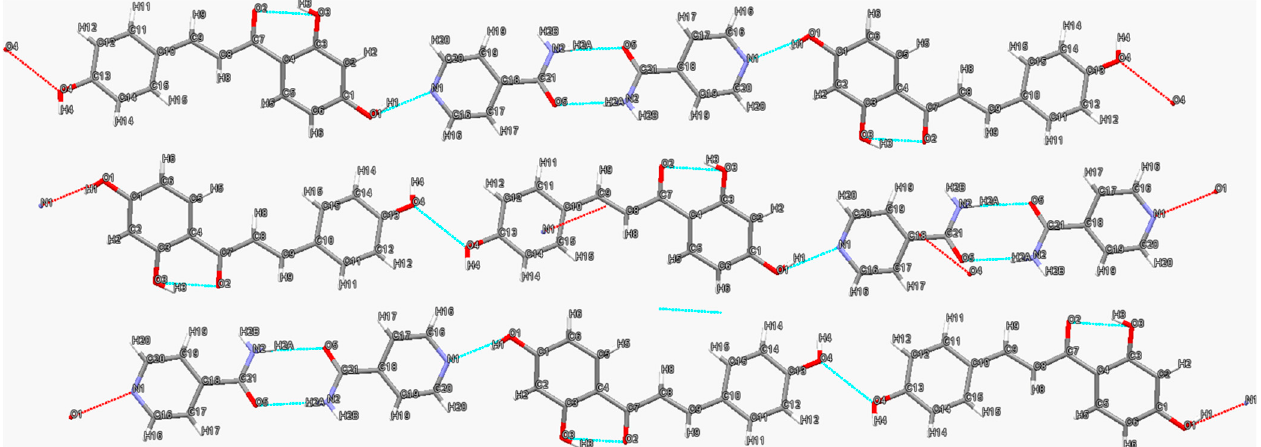
Figure 5. Two-dimensional hydrogen bonding network in isoliquiritigenin–isonicotinamide cocrystal. Hydrogen bonds are represented by blue dashed lines. Red dashed lines indicate further interactions with other molecules not shown.